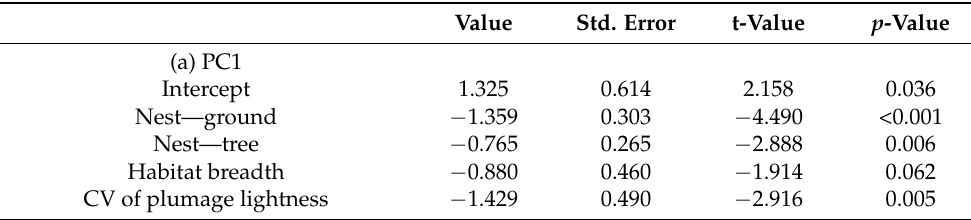
Table 2. Final phylogenetic generalized least square models showing the relationship between (a) the first principal component species scores (PC1), (b) the PC2 and life history traits along urban-rural gradients of central Argentina. Nest in building, dimorphism absence and iridescence absence are included in the intercept.